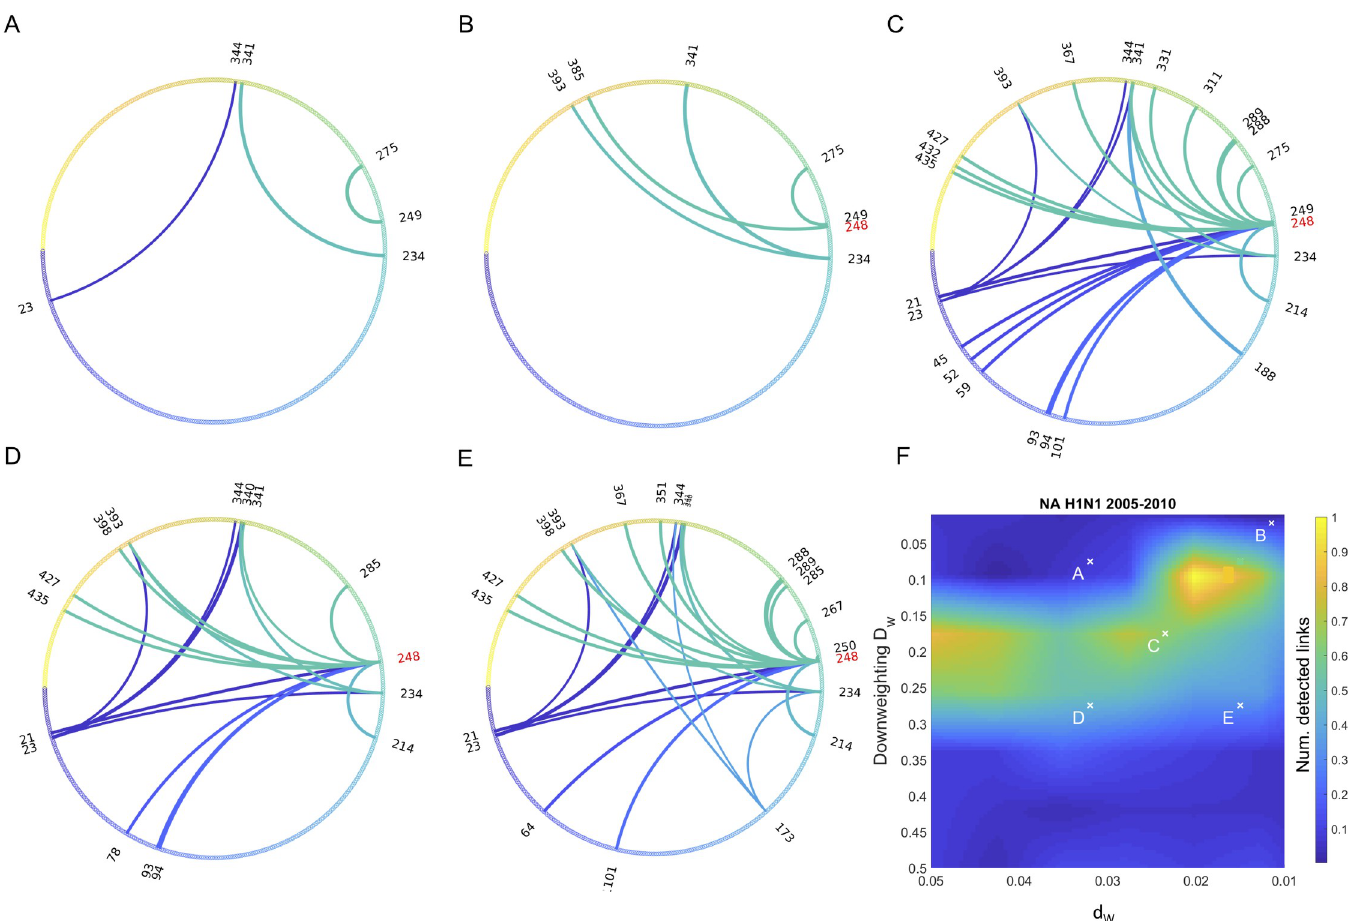
Fig 2. Epistatic network predicted from sequence data on surface protein sequences of Influenza A H1N1 obtained between years 2005 and 2010. The circular diagrams show the network of interaction between variable amino acid sites in the neuraminidase protein. Sequences with homology to the consensus less than d randomly re-sampled 200 times, with their number downweighted by coefficient D w . ( F ) 2D heatmap showing the total number of links as a function of d v (X-axis) and D w (Y-axis) . Different versions of wheels in A-E correspond to different choices of D w and d v shown by crosses in F. All links have estimated E > 0.5. (A-E) Colors correspond to different locations in the protein.